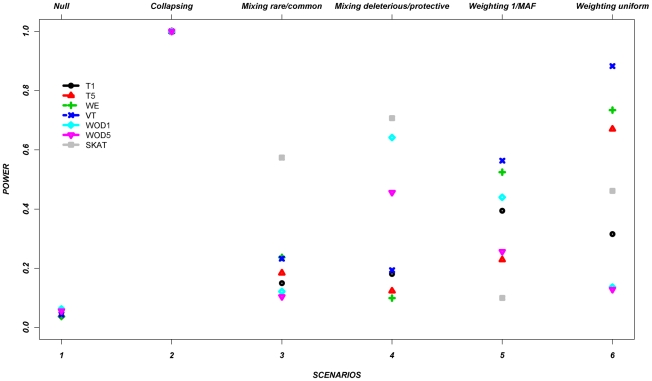
Power across all methods, per scenario, as described in
Table 1
, for the average across the seven genes.Footnote: Note that in some scenarios, different methods overlap. This is the case for scenario 1 and 2, where all methods give similar power.